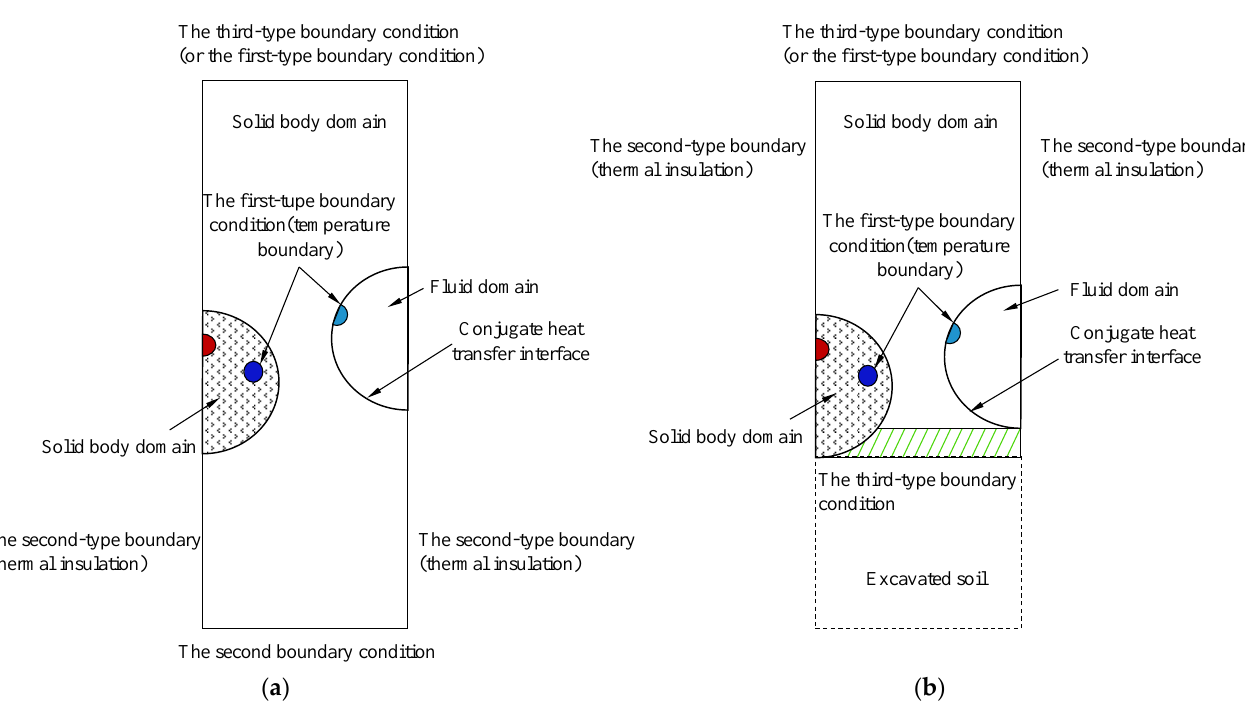
Figure 4. Calculation model of unsteady-state conjugate heat transfer of FSPR method. ( a ) Active freezing period. ( b ) Maintenance freezing period.